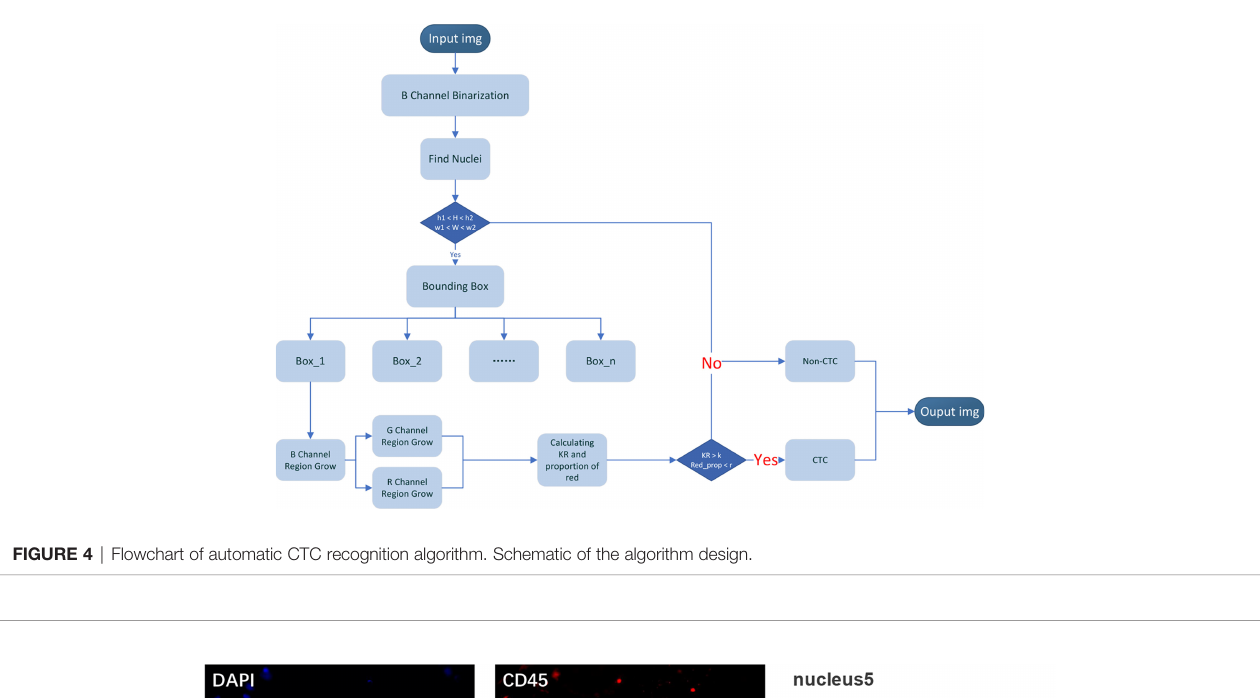
FIGURE 4 | Flowchart of automatic CTC recognition algorithm. Schematic of the algorithm